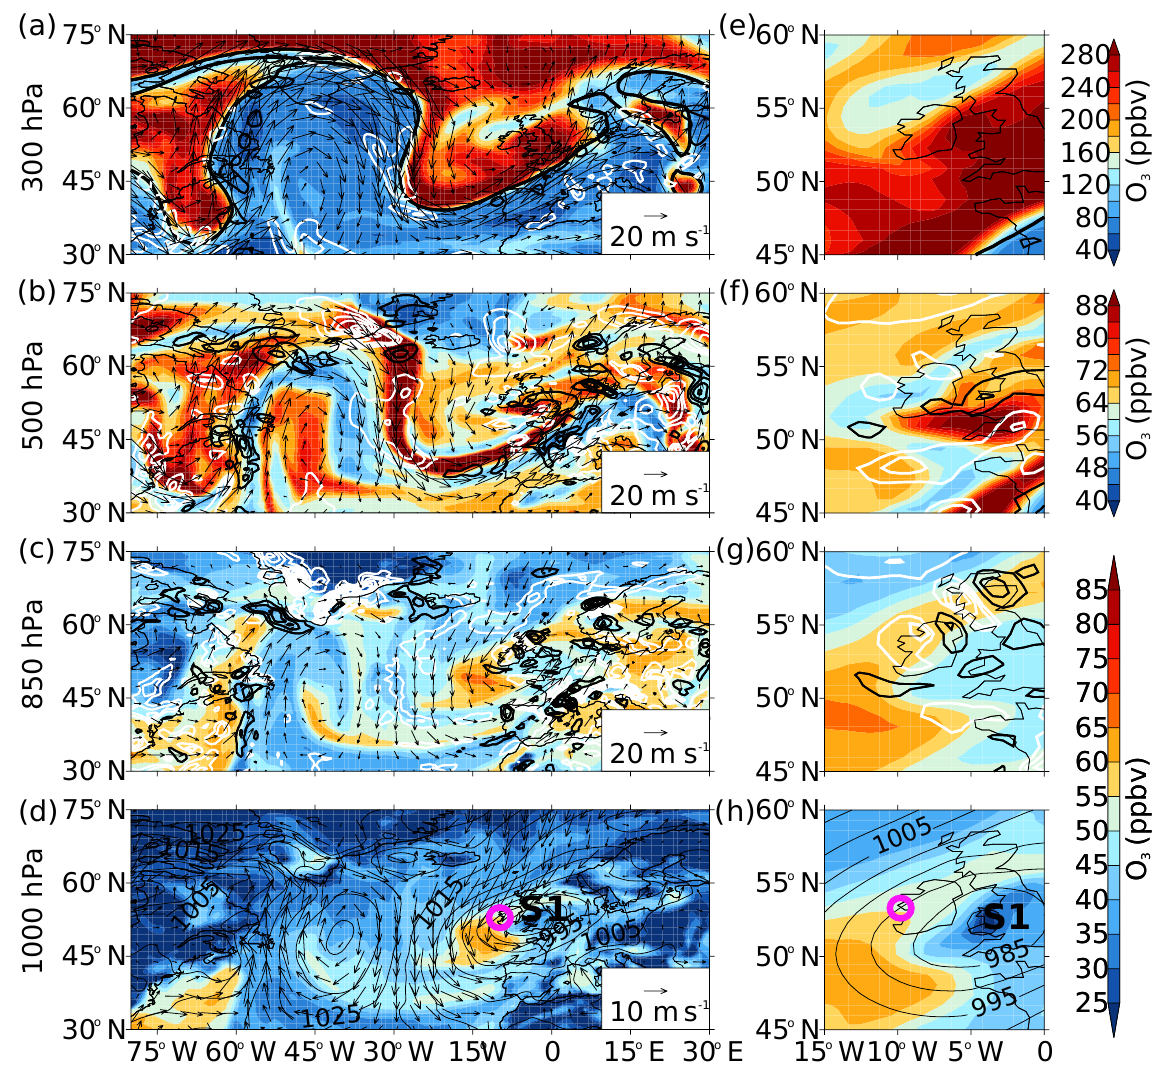
Figure 9. Similar to Fig. 8 ( a–d ) but also includes an inset over Ireland and the UK (45–60 ◦ N, 15 ◦ W–0 ◦ ; e–h , winds not included) for the S1 cyclone ( d ; 51 ◦ N, 5 ◦ W) 18h later, on 25 April 2012 at 18:00UTC for four pressure levels: (a,e) 300hPa, (b,f) 500hPa, (c,g) 850hPa, and (d,h) 1000hPa. High O 3 reported at Mace